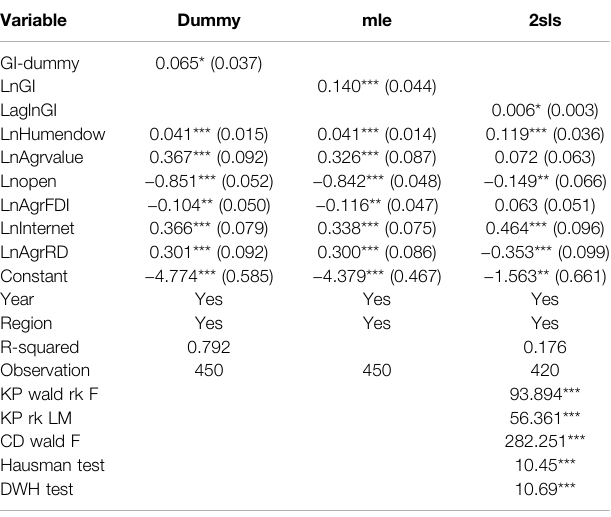
TABLE 4 | Robustness test of the impact of GIC on the technical complexity of export agricultural products. Variable